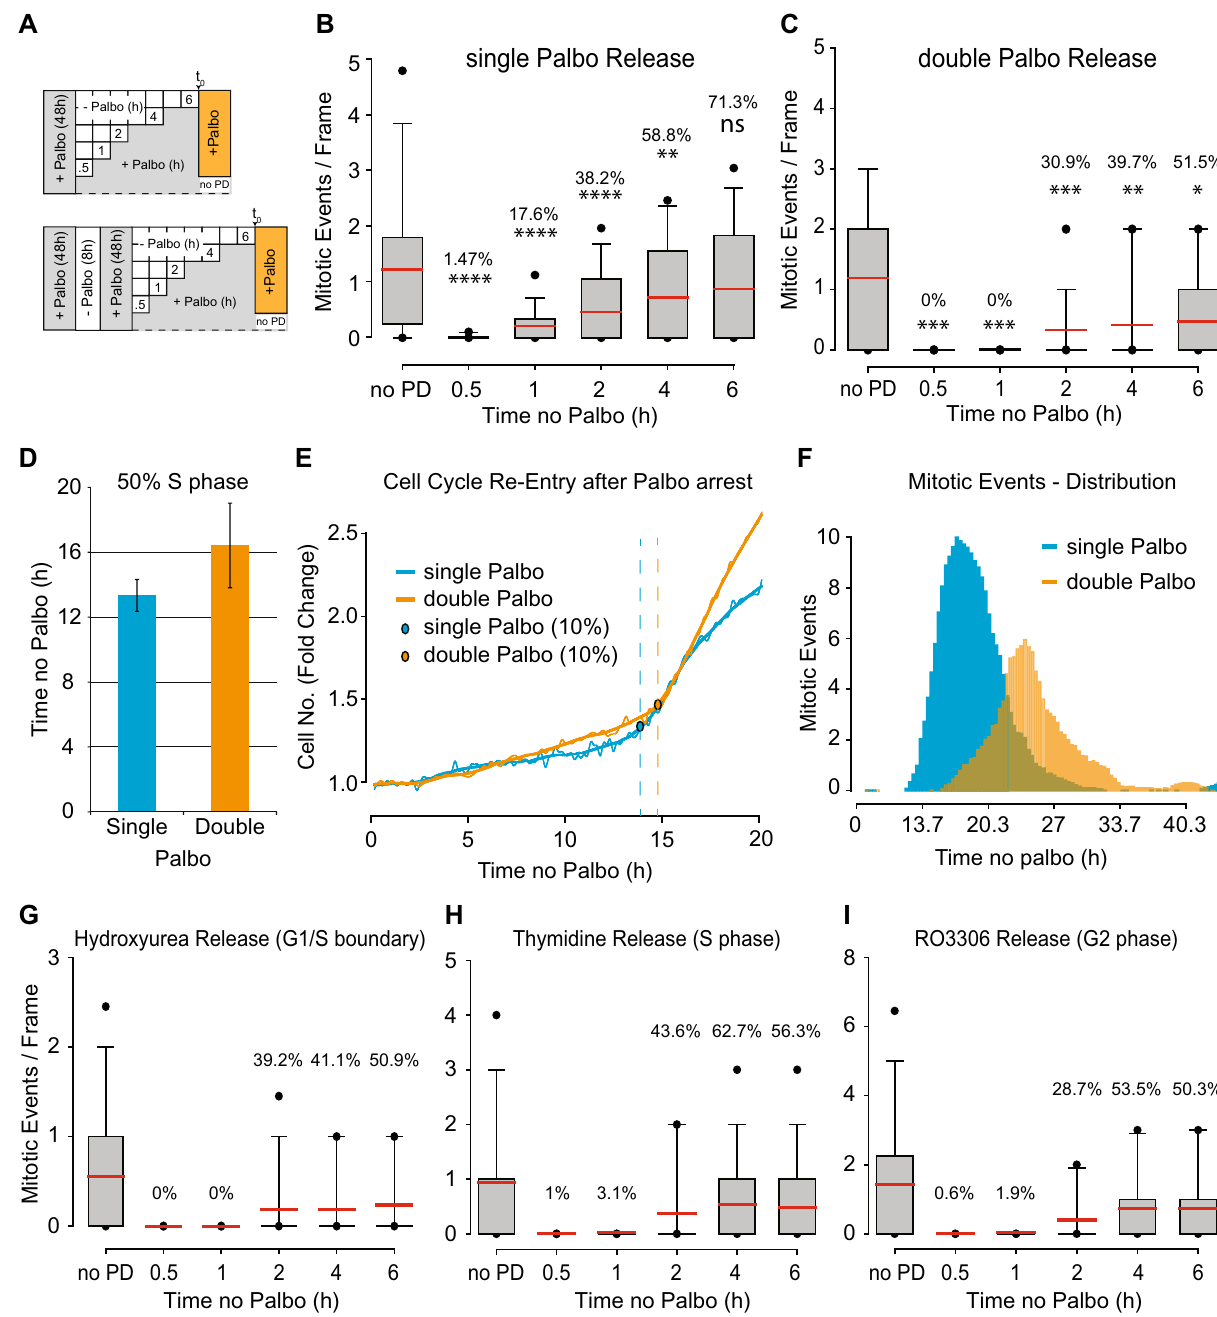
Figure 3. Identification of a cyclin D-dependent phosphorylation gradient during early G1 phase. ( A ) Scheme visualizing the experimental set up of this figure. In short: cells were treated with Palbociclib for the indicated period of time, released and subjected to time-lapse microcopy. ( B , C ) Cells treated as depicted in ( A ) were analyzed for their ability to undergo cellular division. Red bar: average of population, Percentage: percent of cells per time point that undergo cellular division, Asterisks (based on Mann–Whitney-U-Test): ns: p > 0.05, *: p ≤ 0.05, **: p ≤ 0.01, ***: p ≤ 0.001, ****: p ≤ 0.0001. ( D – F ) H2B-eGFP signal of single cell traces of cells from B and C were analyzed for S phase entry ( D – E ) and mitotic division ( F ). Turning points of single cells were set as an increase of 10% in H2B-eGFP signal over 5 time-points (1 h). To ( D ) Bar graph, visualizing the average over all determined single cell turning points of B and C. To ( E ) H2B-eGFP single cell traces of cells from B and C. Blue and orange circles: turning points. To ( F ) Distribution of mitotic divisions from cells in B and C. ( G – I ) Cells release from a single Palbociclib arrest in a step-wise manner if previously synchronized outside of G1 phase. Percentage: percent of cells per time point that undergo cellular